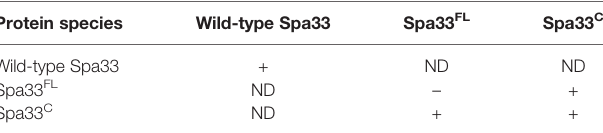
TABLE 2 | Speci fi c Spa33 interactions can be identi fi ed by two-hybrid a analysis. Protein